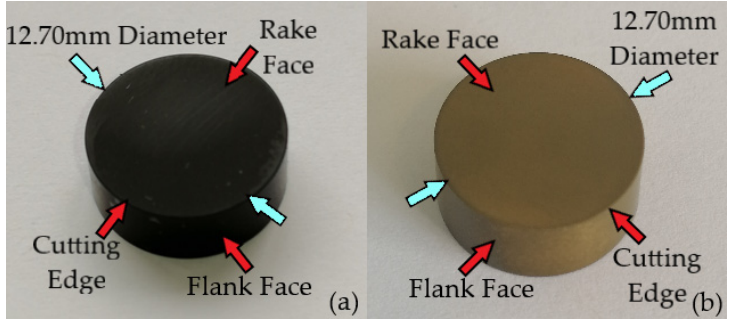
Figure 1. Typical inserts before use ( a ) CTIS710 SiAlON ceramic + Type A coating — CVD 6 µm thick TiN-TiCN-Al 2 O 3 coating with α -Al 2 O 3 ( black colour); ( b ) CTIS710 SiAlON ceramic + Type B coat-